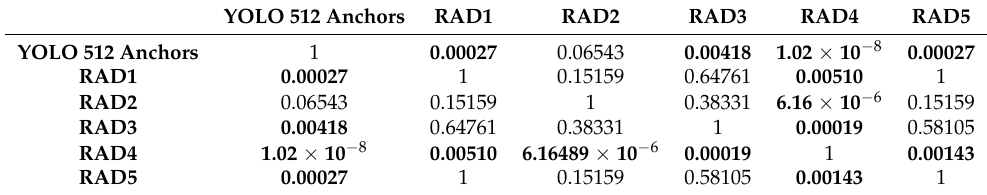
Table A4. McNemars’ test for radiologists vs. AI comparison. Bolded values represent statistical significance at the p < 0.01 level.